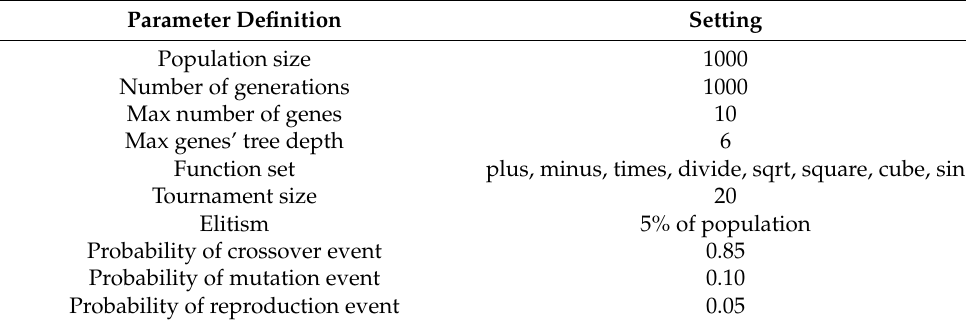
Table 3. Parameter settings for the MGGP model.